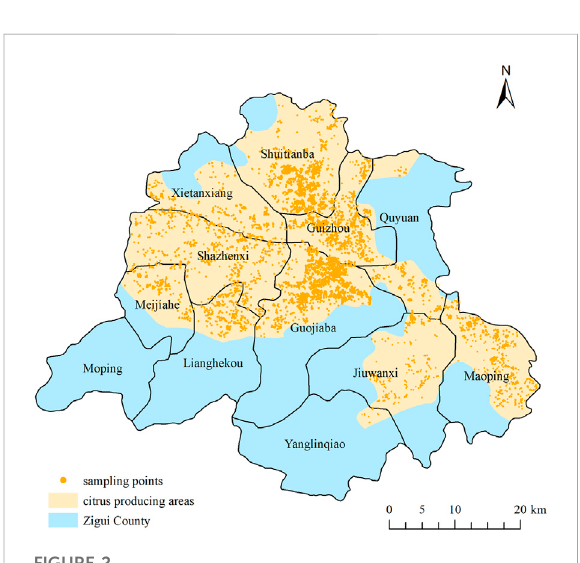
FIGURE 2 The spatial distribution of the soil samples in Zigui